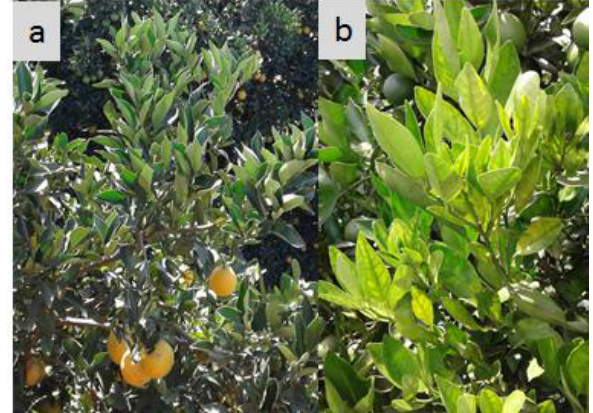
Figure 3. (a) Healthy orange. (b) Orange with HLB.